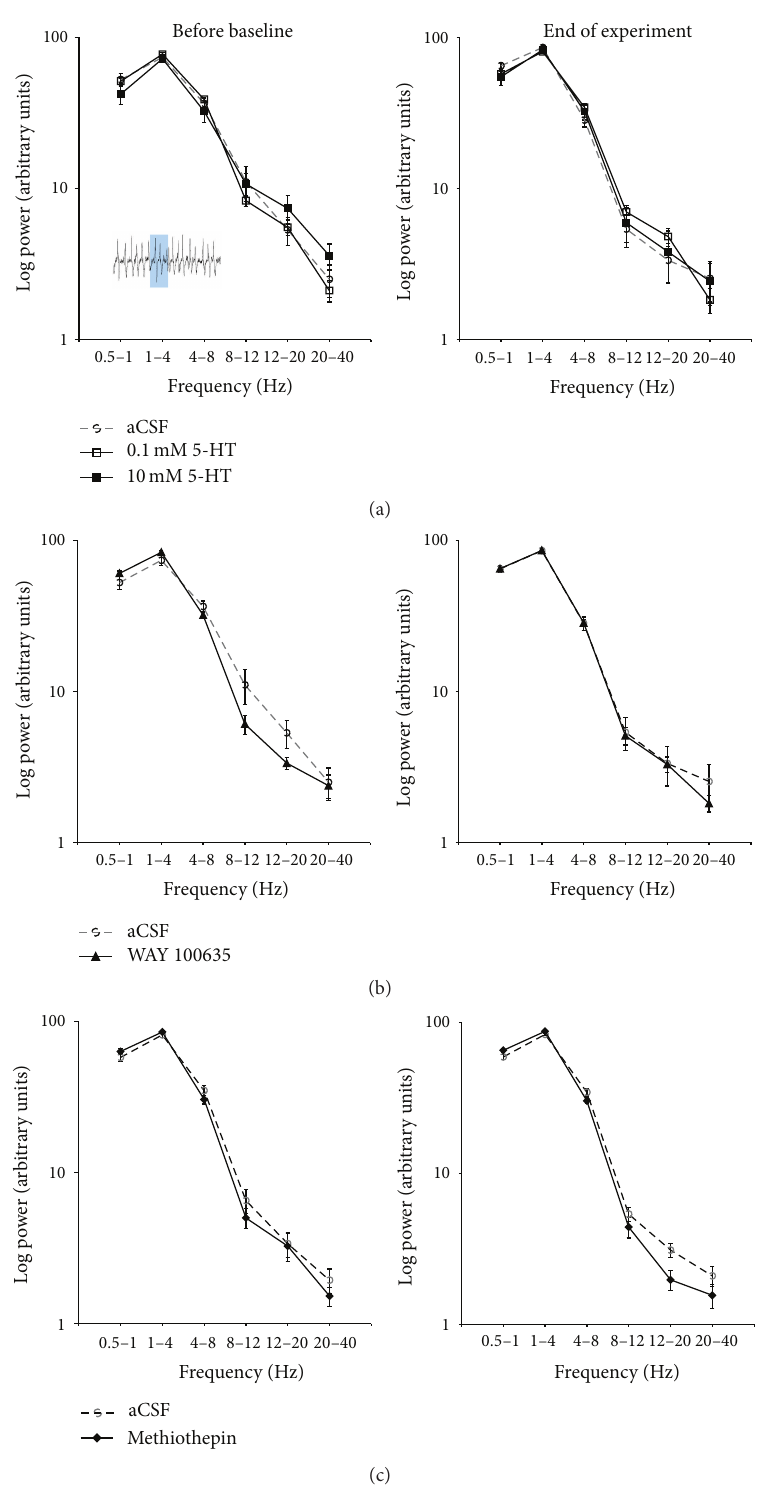
Figure 8: The effect of application (in V1 by means of reverse microdialysis; starting 20 min prior to the onset of recordings) of either aCSF, 5-HT (top; 0.1 and 10mM), WAY 100635 (middle; 1mM), or methiothepin (bottom; 1mM) on electrocorticographic (ECoG) activity in V1 of adult, urethane-anesthetized rats. The ECoG was recorded and analyzed (5sec epochs) by power spectral analysis before the onset of baseline recordings and at the end of the experiment. Throughout the experiment, ECoG activity was dominated by large amplitude, slow activity, with most power concentrated in the low delta (0.5–1Hz) and delta (1–4Hz) frequency bands. None of the pharmacological treatments resulted in a significant change in ECoG activity. Insert depicts typical ECoG activity in V1, with the shaded area representing a 5sec epoch used for the analysis (group sizes the same as those in previous